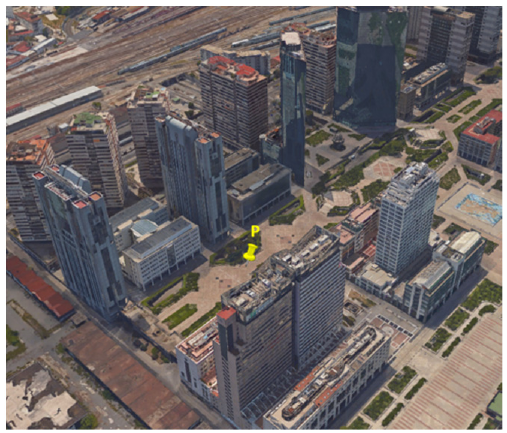
Figure 2. Scenario of the test at the “Centro Direzionale”, Naples,